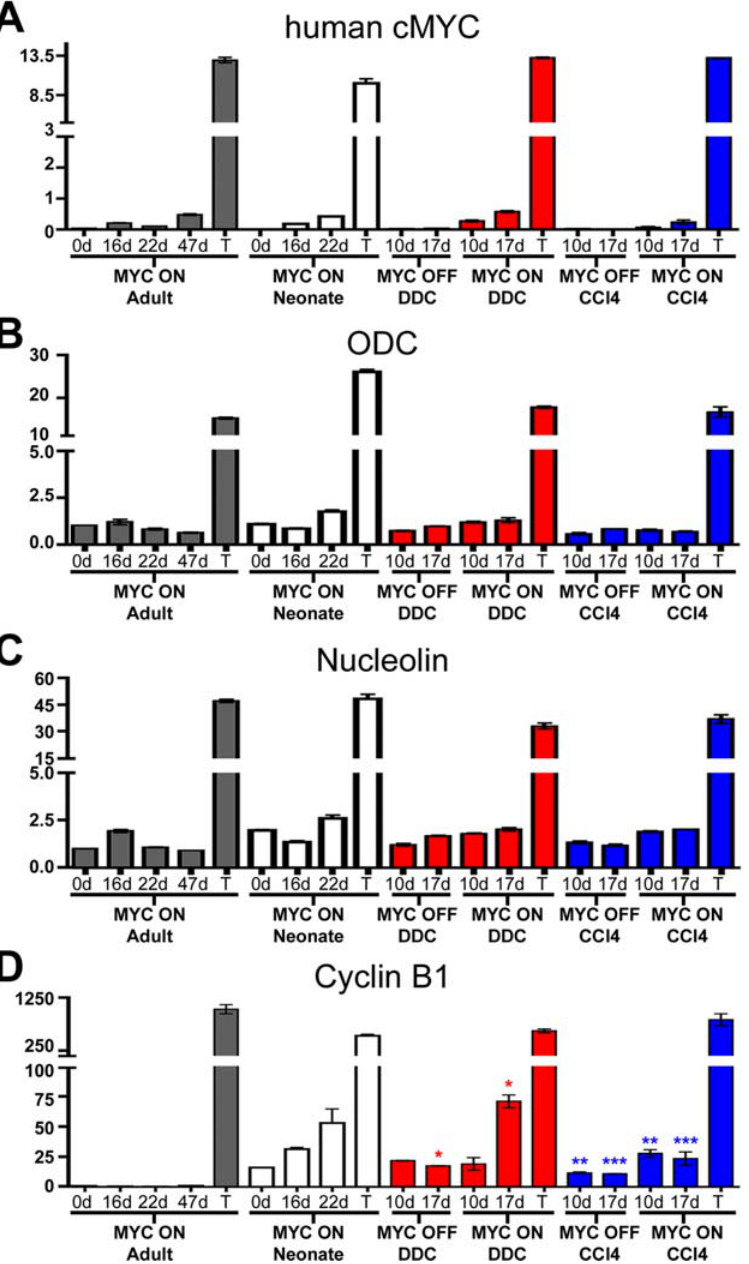
Figure 7. MYC-induced Proliferation and Tumorigenesis in Hepatotoxin-Treated Livers is Associated with Increased Cyclin B1 Expression. Real-time quantitative PCR of: (A) human c-MYC mRNA, (B) mouse Ornithine Decarboxylase (ODC) mRNA, (C) mouse Nucleolin mRNA, and (D) mouse Cyclin B1 mRNA. Statistical significance was measured using a Mann Whitney test (* P , 0.05, ** P , 0.05, *** P , 0.05). Gray bar graphs represent normal adult livers in which MYC was overexpressed for the times indicated. White bar graphs represent normal neonatal livers in which MYC was overexpressed. Red bar graphs represent DDC-treated livers in which MYC was either overexpressed (MYC ON/DDC) or kept inactive (MYC OFF/DDC). Blue bar graphs represent CCl 4 -treated livers in which MYC was either overexpressed (MYC ON/ CCl 4 ) or kept inactive (MYC OFF/ CCl 4 ). mRNA was quantitated from four different liver samples per time-point.